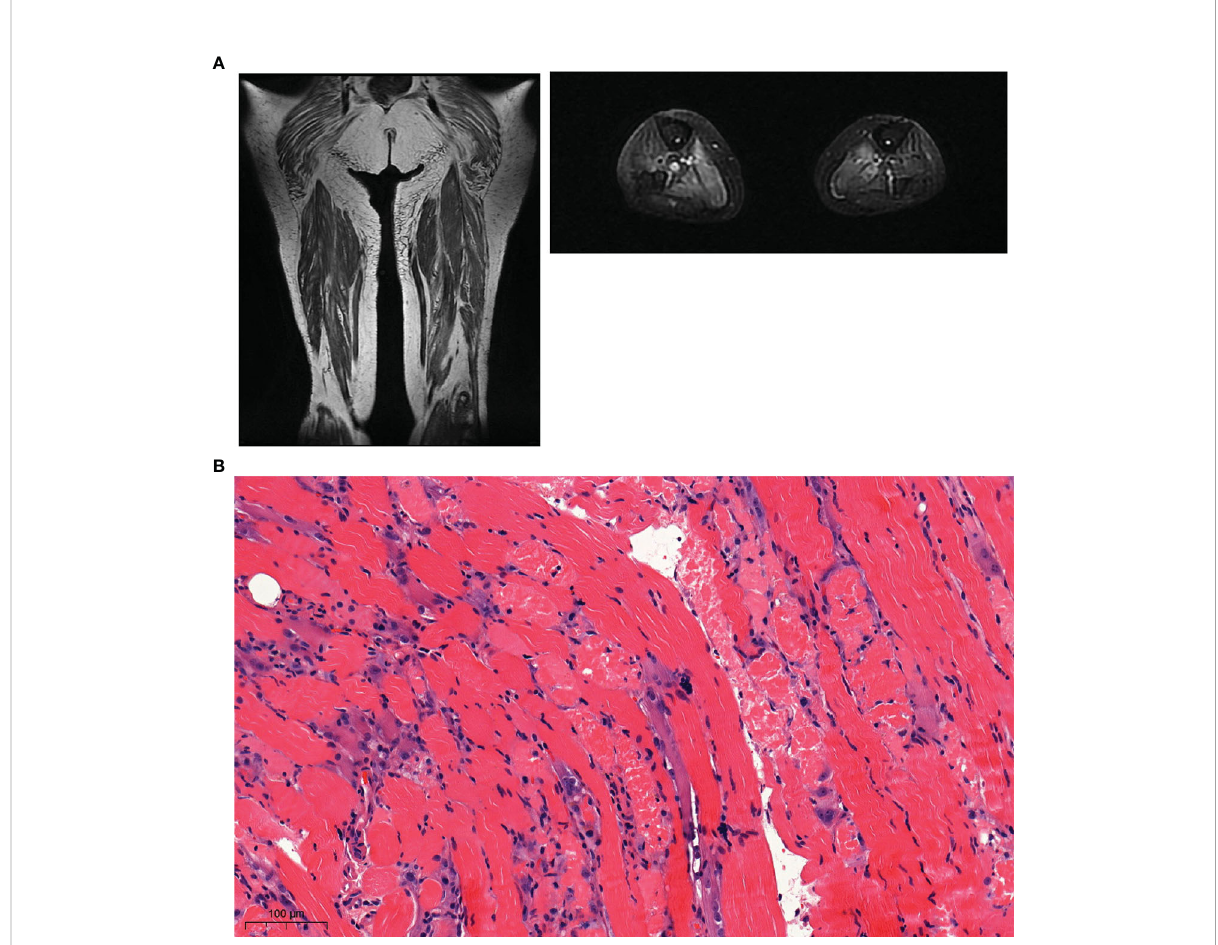
FIGURE 2 (A) Magnetic Resonance Imaging (MRI) of muscles of lower limbs, T1 Coronal and T2 axial reconstruction. MRI shows pathological bilateralhypersignal of proximal muscles: gluteal muscles, medial gastrocnemius muscles, solar muscles with relative respect of semitendinosus muscles. (B) Immuno-histo-chemical staining of the muscle biopsy. Standard muscle biopsy stain exhibiting muscle atrophy, degeneration, necrosis, macrophagic in fi ltration and muscle fi ber